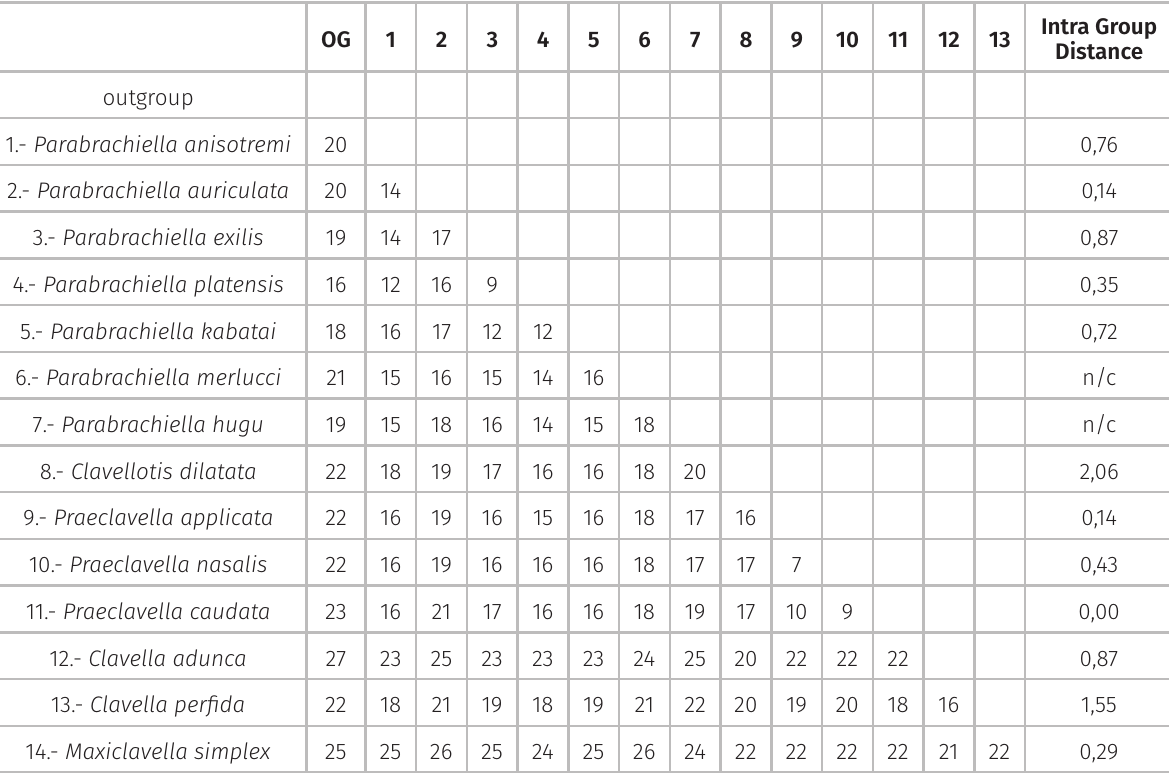
Table I. Genetic distances matrix (uncorrected p-distance) for copepods used in this manuscript. The percentage values are derived from the COI